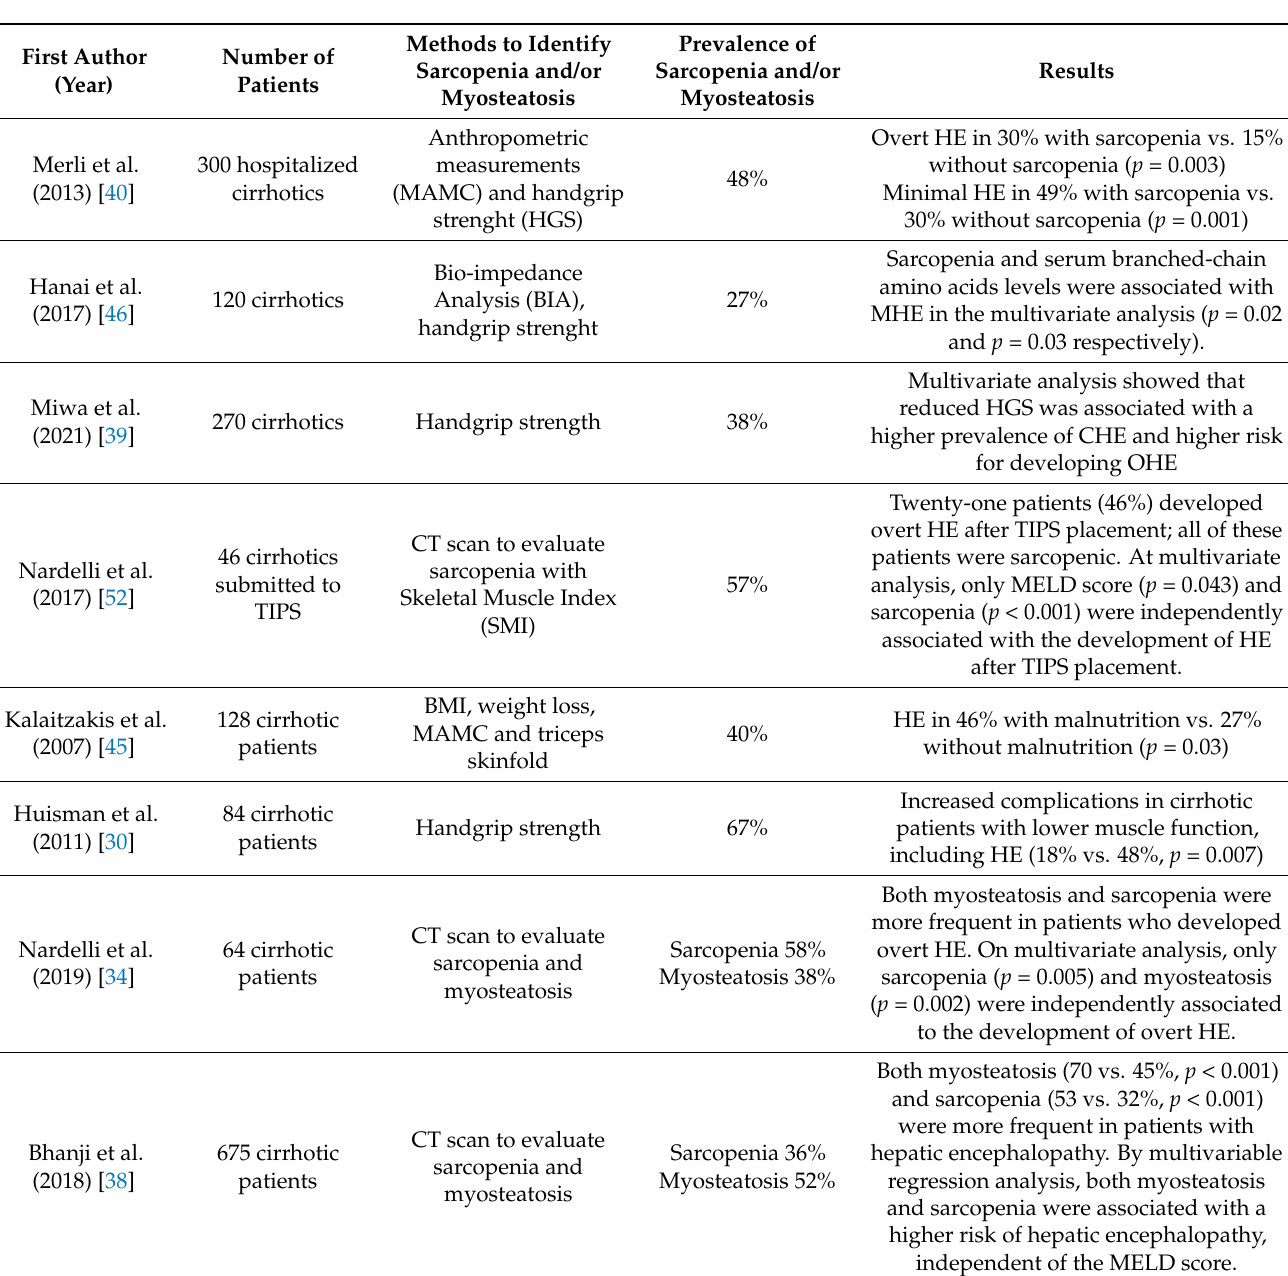
Table 1. Studies evaluating the relationship between muscle alterations and hepatic encephalopathy in